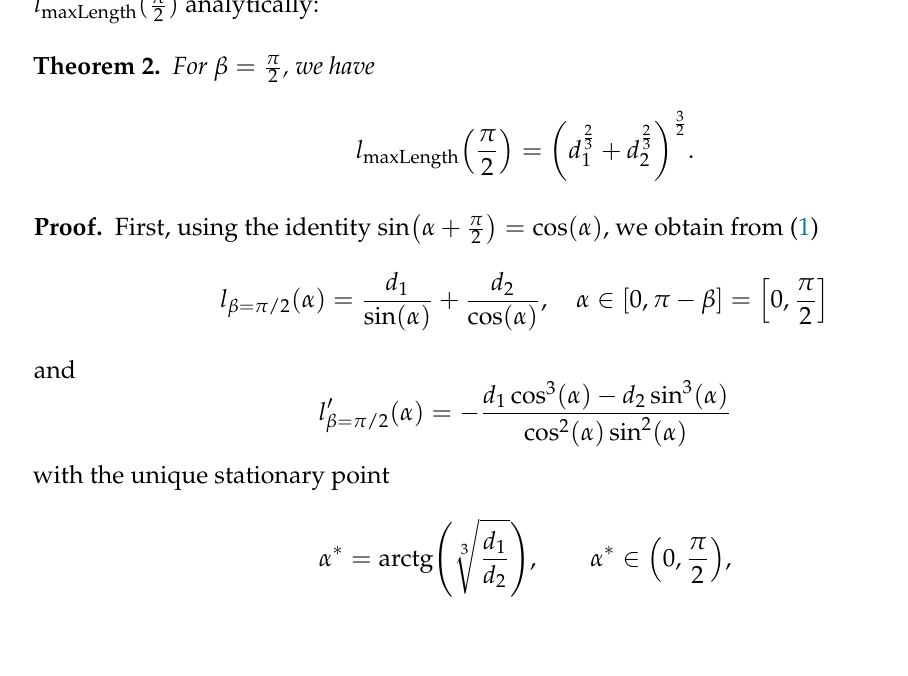
Figure 2. The objective function l β ( α ) and its second derivative for β = π interval [ 0, π − β ]